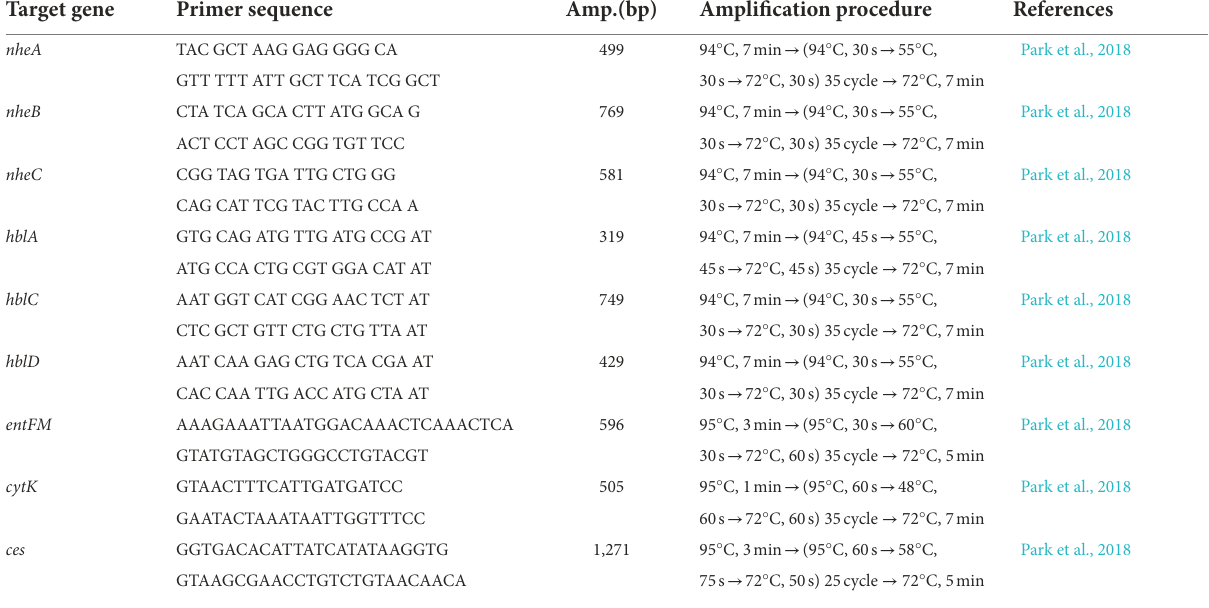
TABLE 1 Primer sequences and PCR amplification procedures used in this study. Target